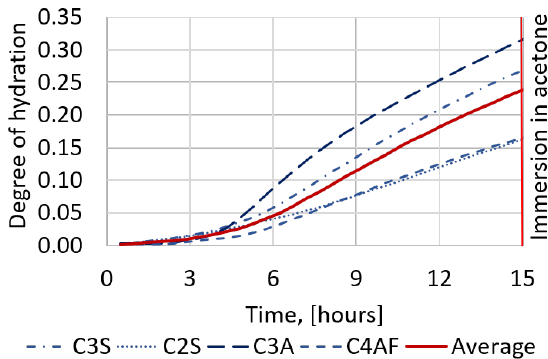
Figure 3. Capillary porosity.